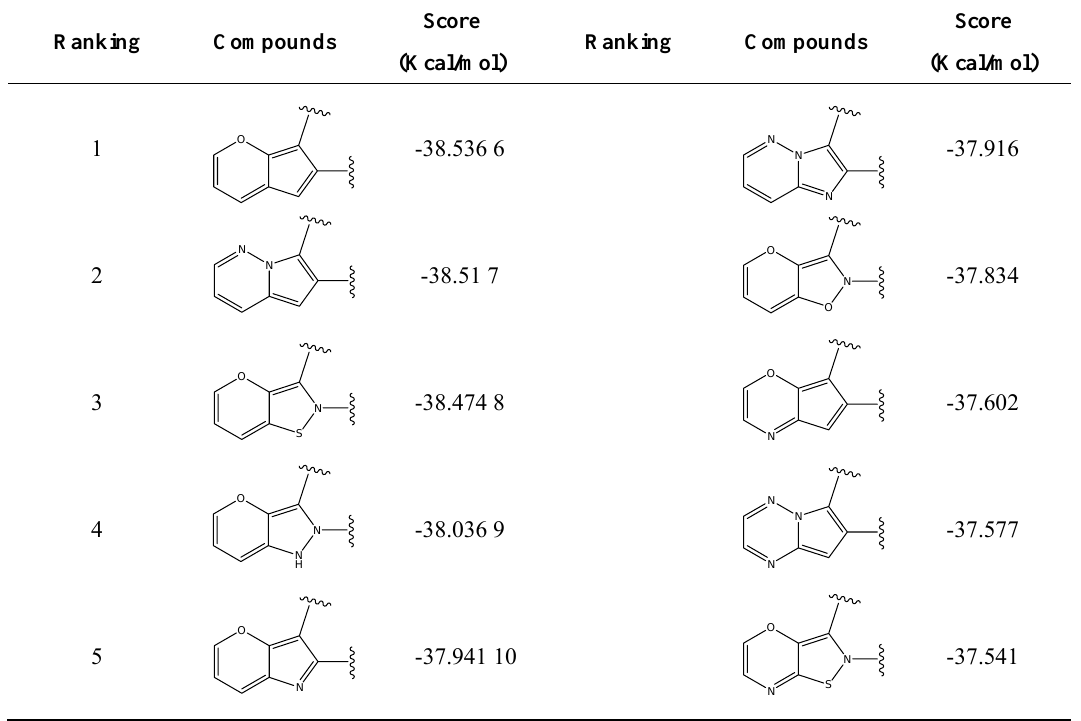
Table 2. The 10 highest scoring FPH substitutions for the FPH-p38 MAN kinase complex.